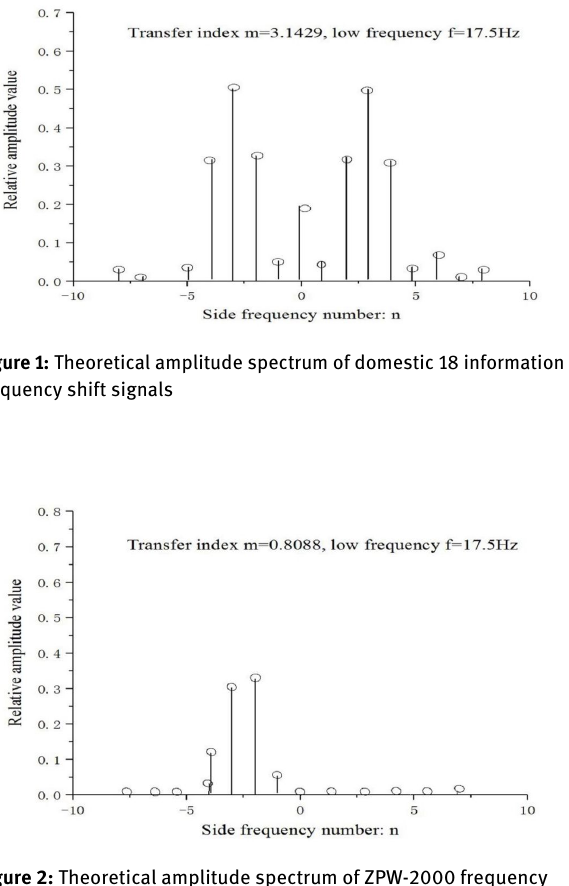
Figure 2: Theoretical amplitude spectrum of ZPW-2000 frequency shift